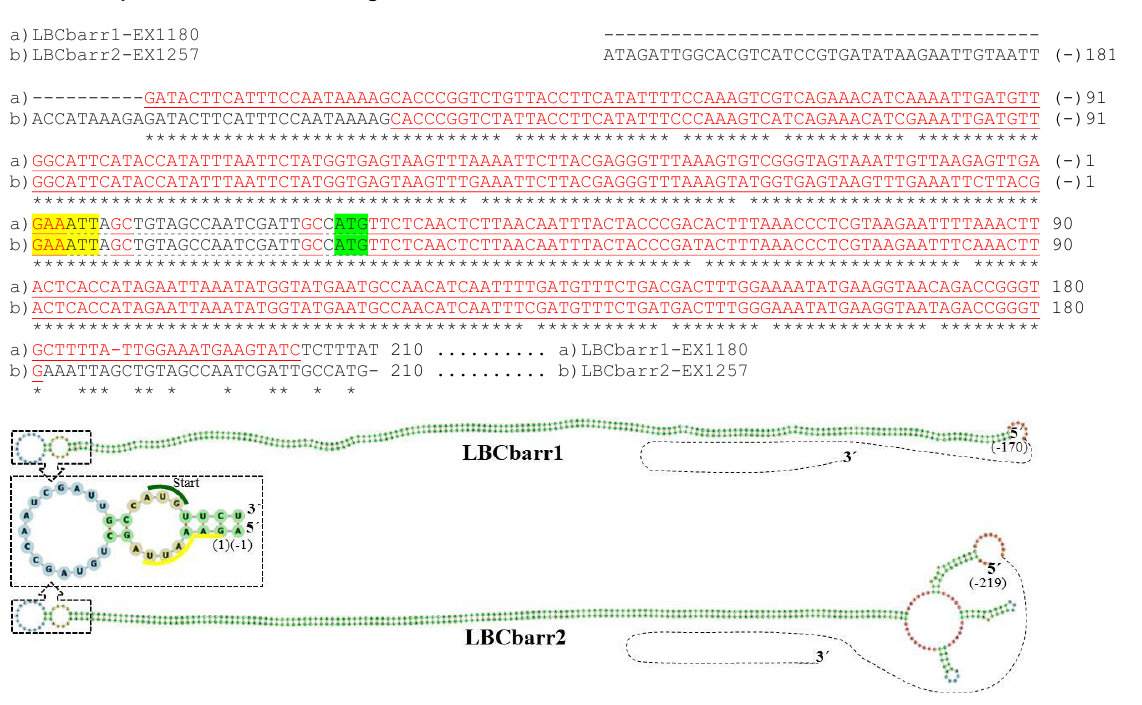
Figure 2. cDNA of 5 ′ -extra sequences and proximal canonical sequences of TdV-LBCbarr1 genome from EX1180 strain and TdV-LBCbarr2 genome from EX1257 strain. The 5 ′ -GAAATT end of the canonical sequence is yellow highlighted. The protein synthesis initiation codon of Gag-Pol is green shaded. Nucleotides of palindromic sequences are shown in red letters. The stem-loop sequences are underlined. The unpaired nucleotides of each loop are dot underlined. Asterisks (*) indicate identical nucleotides. The secondary RNA structures of possible 5 ′ stem-loops are shown at the bottom of the sequences. No relevant identity was detected between the 5 (cid:48) - or 3 (cid:48) -extra sequences of V-LBC genomes from T. delbrueckii and S. cerevisiae . However, high local identity between the 5 (cid:48) - or 3 (cid:48) -extra sequences from Td-LBCbarr viruses, and between the 5 (cid:48) -extra sequences from Sc-LBC viruses was found (Figures 2–4). No relevant identity between the 3 (cid:48) -extra sequences from Sc-LBC viruses was found (Figure